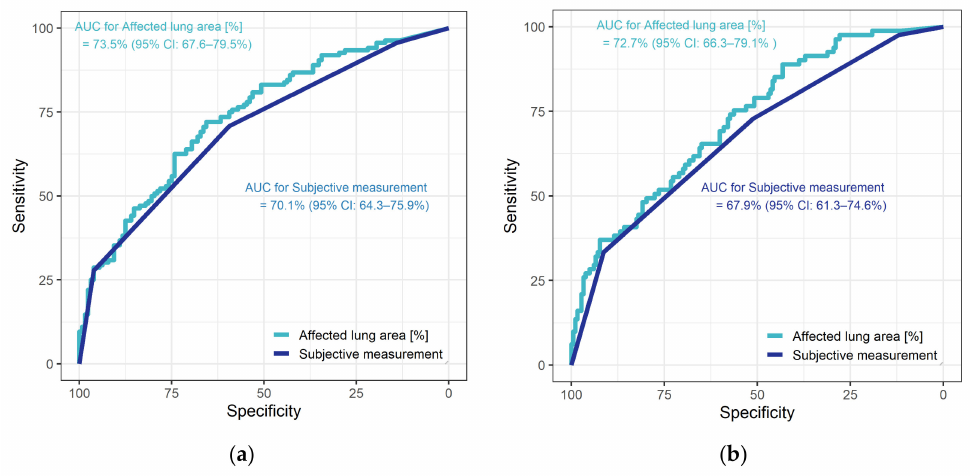
Figure 3. Diagnostic performance of subjective assessment and of the SSQ method for the two endpoints: ( a ) need for ICU treatment, ( b ) need for invasive ventilation.